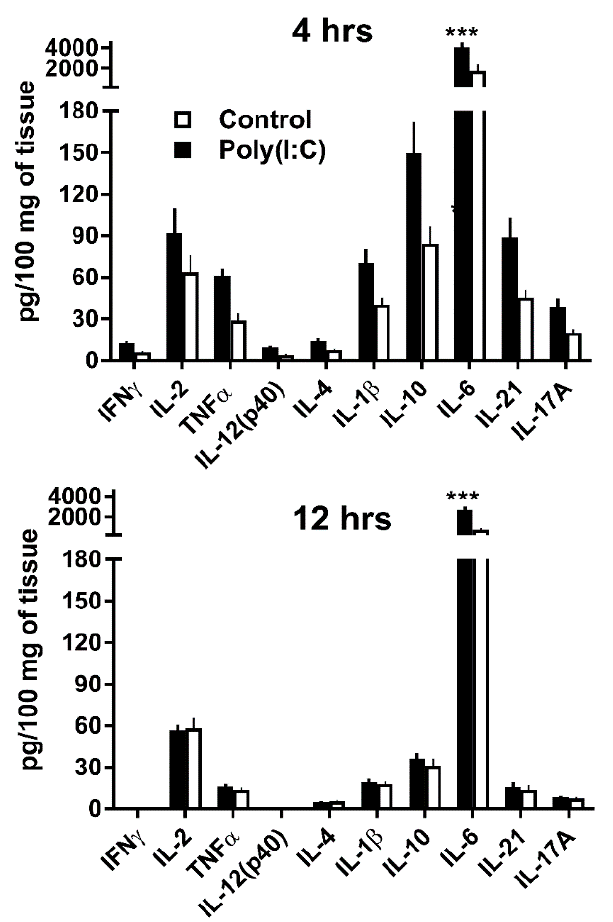
Figure 2. Endogenous cytokine expression in gonadal white adipose tissue (GWAT) explants in response to poly(I:C). GWAT explants were excised from C57Bl / 6J mice and treated with 5 µ g / mL of poly(I:C) or left untreated (black and white bars, respectively). Endogenous expression of cytokines were measured at 4 and 12 h post-treatment. Bars represent average values from two independent experiments (total n = 7). Errors bars denote SEM. *** p value ≤ 0.01 according to Sidak’s multiple comparisons test.